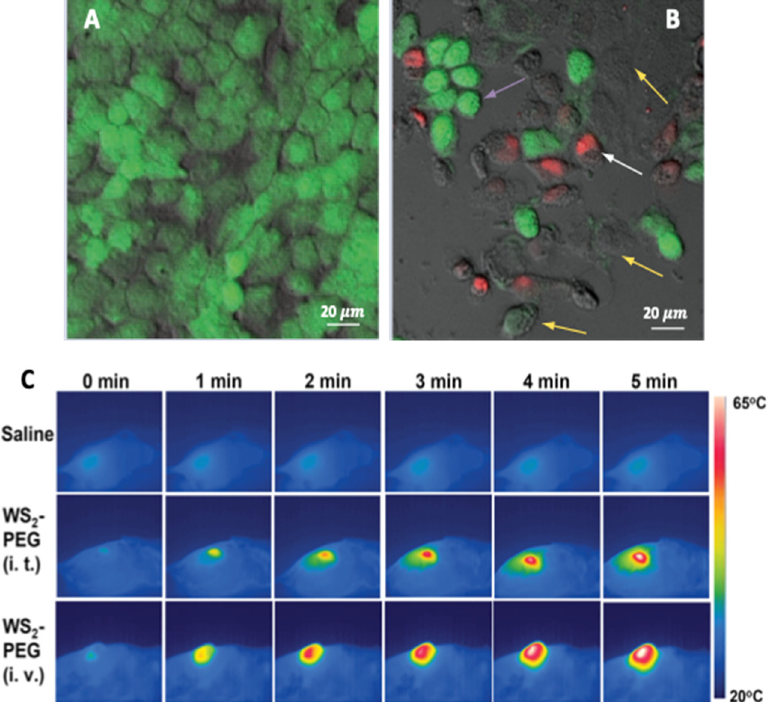
Figure 5. Microphotographs of HeLa cells with CuS-NPs. ( A ) without laser, cells were viable and had polygonal morphology. ( B ) with NIR laser irradiation at 24 W cm − 2 for 5 min (purple arrows show shrinking of cells; yellow arrows show loss of cell viability by calcein-negative staining; white arrows show loss of cell membrane integrity by EthD-1 positive staining. ( C ) In vivo PTT in 4T1 tumor bearing mice with saline (top row), WS 2 -PEG (middle row: i.t. low dose = 2 mg kg − 1 ), WS 2 -PEG (bottom row: i.t. high dose = 20 mg kg − 1 ). The laser power density was 0.8 W cm − 2 . Reprinted with permission from Refs. [64,68]. Copyright © 2023, Future Medicine and 2014, Wiley.